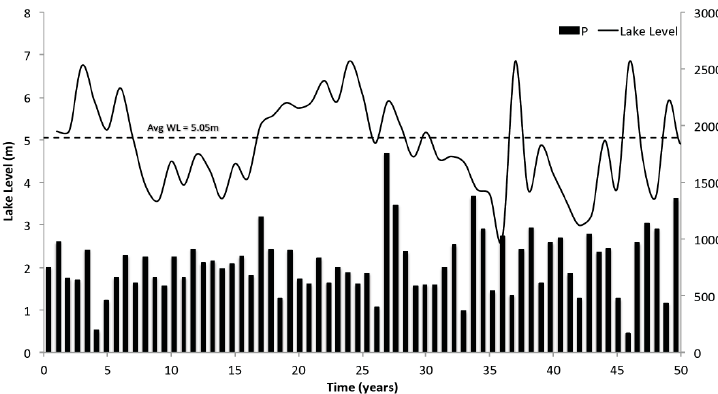
Figure 7. Simulation of Lake Babati level variation based on a 50-year random precipitation time series generated using historical mean and standard deviation values of precipitation for the period 1973 to 2009.